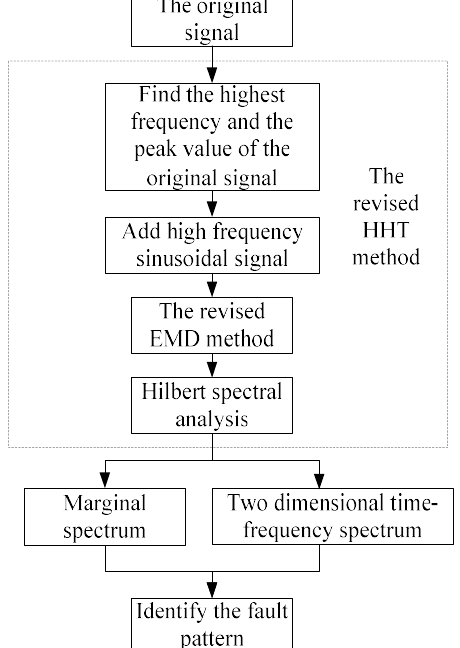
Figure 25. The flow chart for signal analysis. HHT, Hilbert–Huang transform.